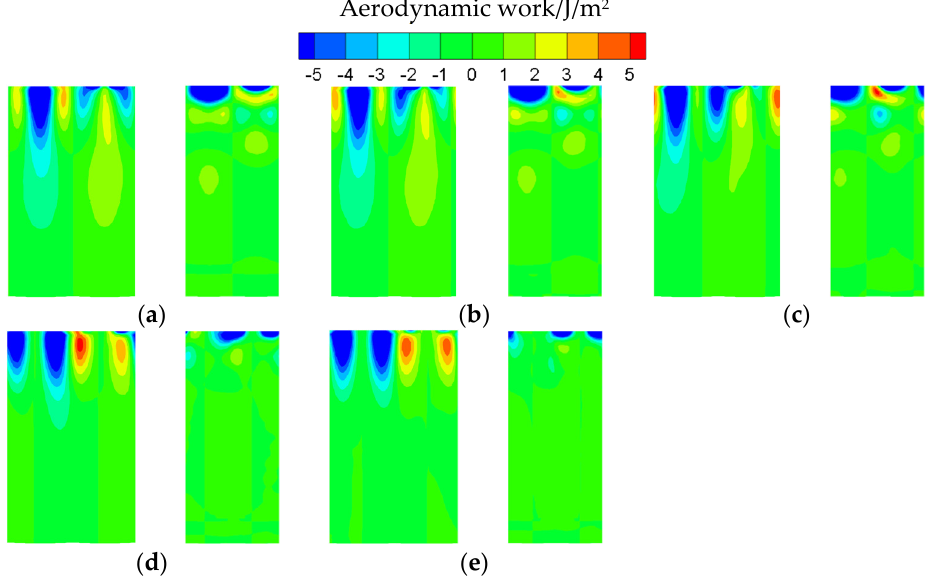
Figure 13. Aerodynamic work distribution of the coupled modes: ( a ) ( c ) a c = 0.50; ( d ) a c = 0.75; ( e ) a c =